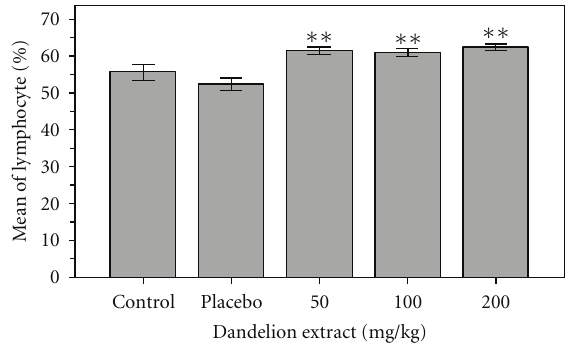
(mg/kg)Control Placebo Dandelion extract Figure 3: Comparison of mean lymphocytes between the experi- mental groups, control and